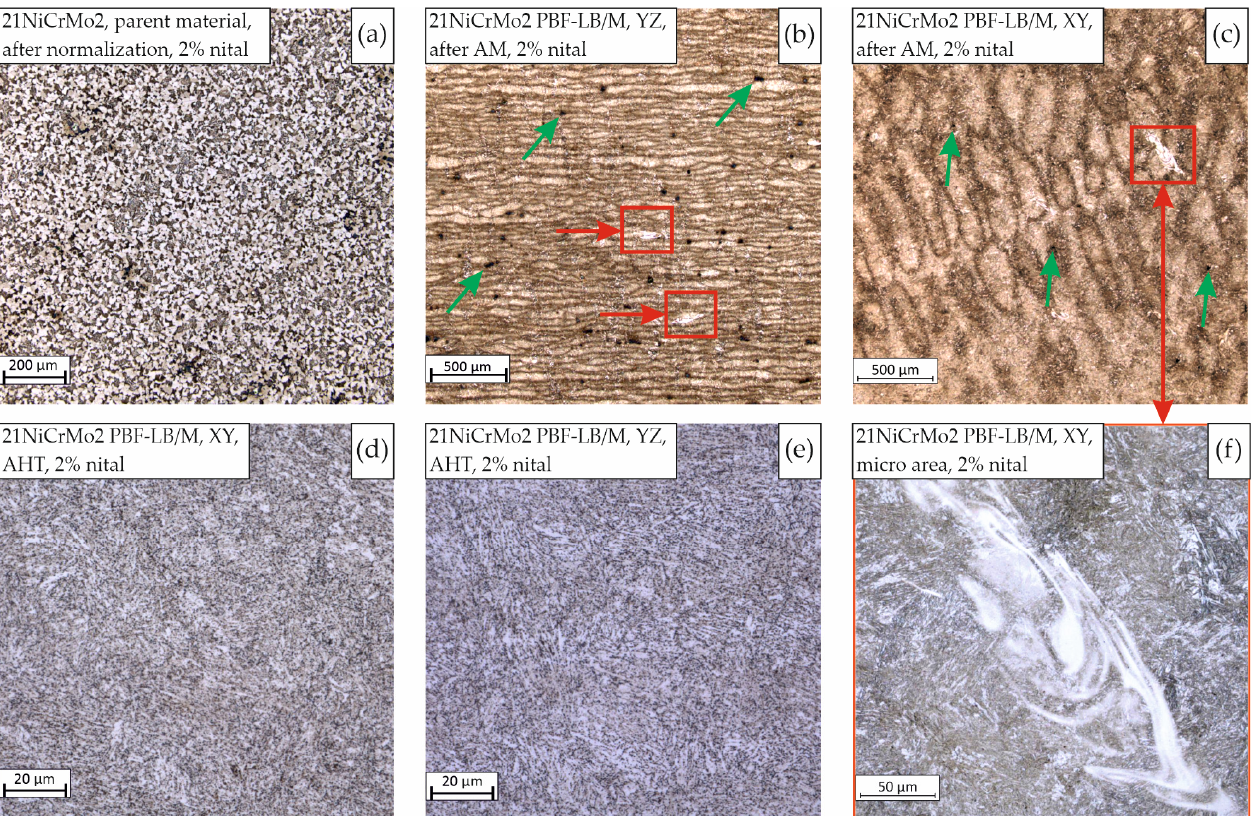
Figure 5. 21NiCrMo2 microstructure images, 2% nital etched, obtained conventionally ( a ) and via the PBF-LB/M process in both planes: XY ( b ) and YZ ( c ); after being subjected to heat treatment (AHT) and PBF-LB/M—XY ( d ), and YZ ( e ) with the visible heterogeneous micro-area of concentrated alloy elements ( f ).